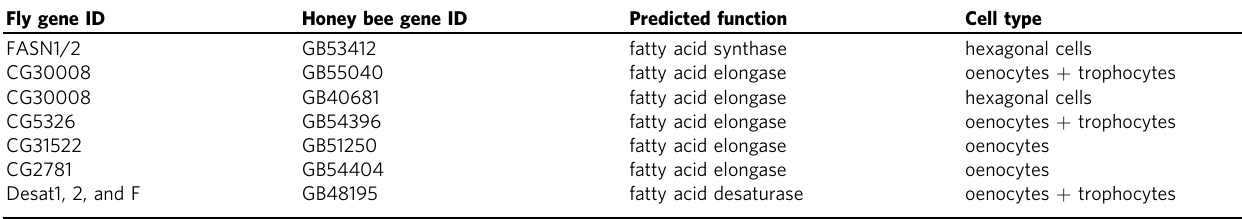
Given are 1) the fl y and 2) the honey bee gene IDs, 3) the genes ’ predicted functions, and 4) the expression of the candidate genes in honey bee fat body